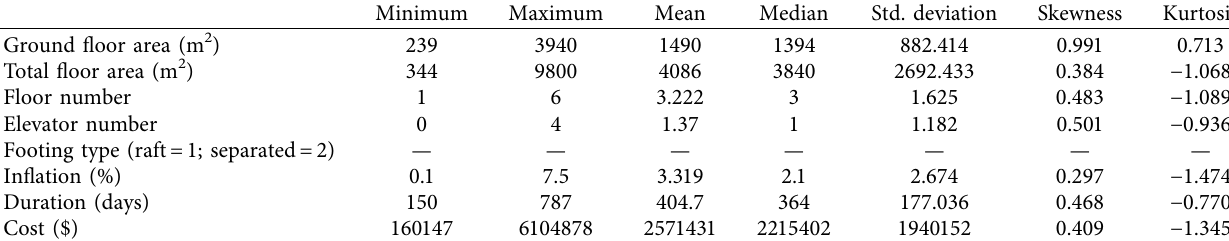
Table 2: Descriptive measures of the cost data for the testing